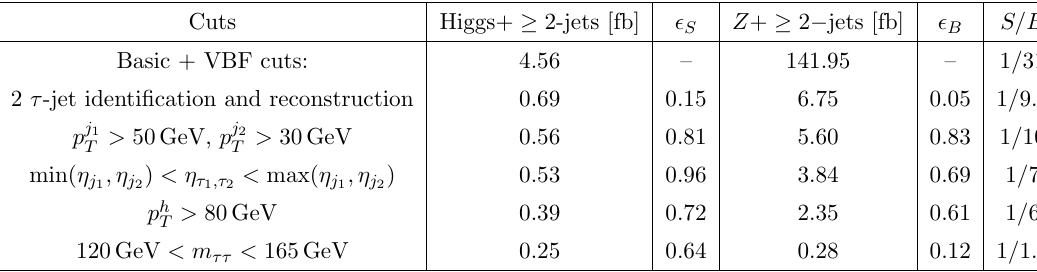
Table 1 . Signal and background cross-sections at the 14 TeV LHC after di(cid:11)erent cuts on the kinematic observables; see text for details on the selection criteria. The e(cid:14)ciency of each cut on the signal ( (cid:15) S ) and background rate ( (cid:15) B ), along with the signal to background ratio ( S=B ) are also shown. We show results with (cid:1) = 0 for the signal rates, although in our parametrization (eq. (2.1)), the total rate is independent of